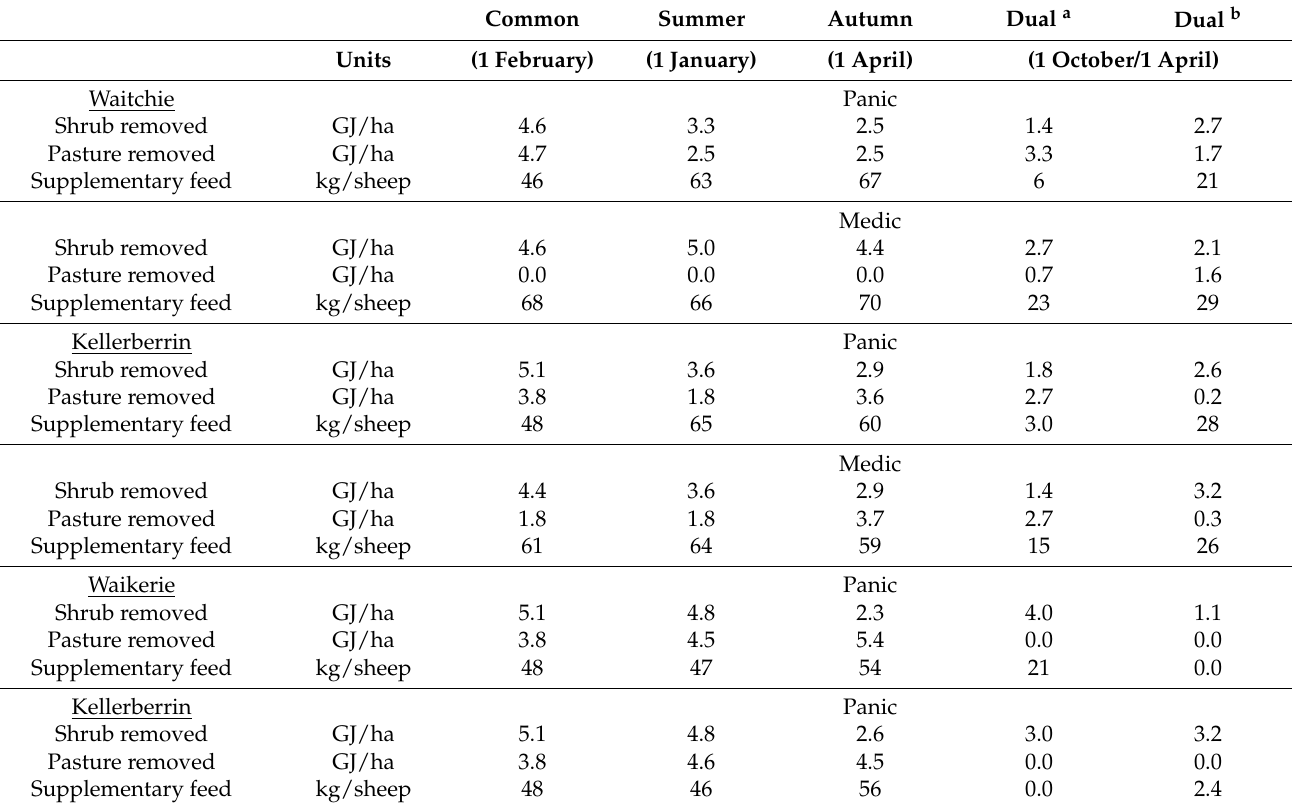
Table 3. Feed removed from different sources (i.e., shrubs, pasture or supplementary feed) for a panic and medic pasture over 90-day periods starting in low rainfall years (lowest 20% of simulation period) at the three study locations. Dual shows the total amount for the full grazing period. Dual a sheep are removed if there was no shrub or interrow biomass remaining in the October grazing period; Dual b sheep are retained for the full period on both